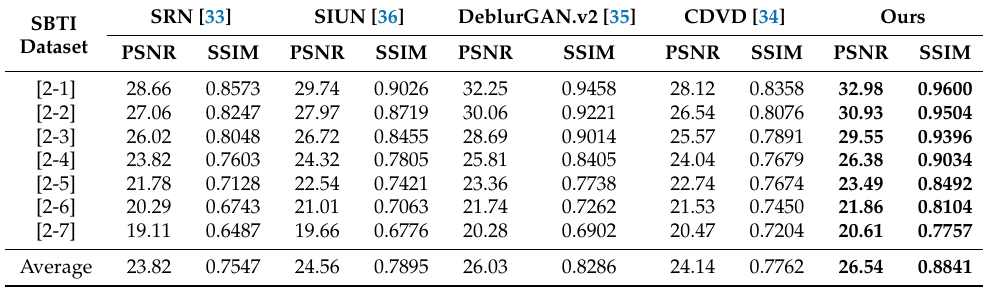
Table 5. Comparison of quantitative deblurring performance on the SBTI dataset [2-1]–[2-7].